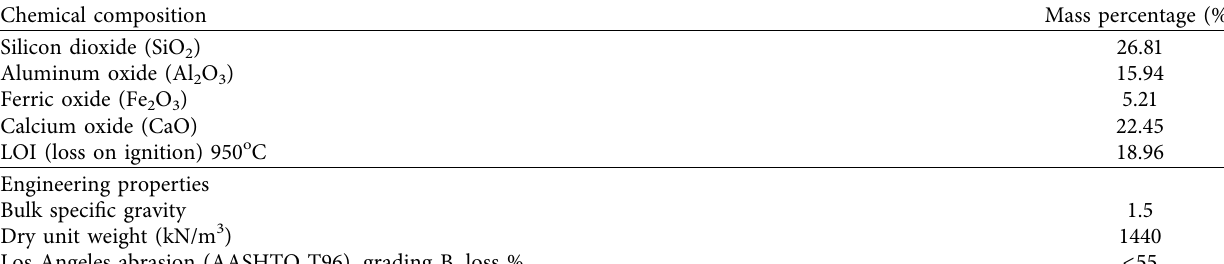
Table 1: Chemical constituent and engineering properties of the HFA